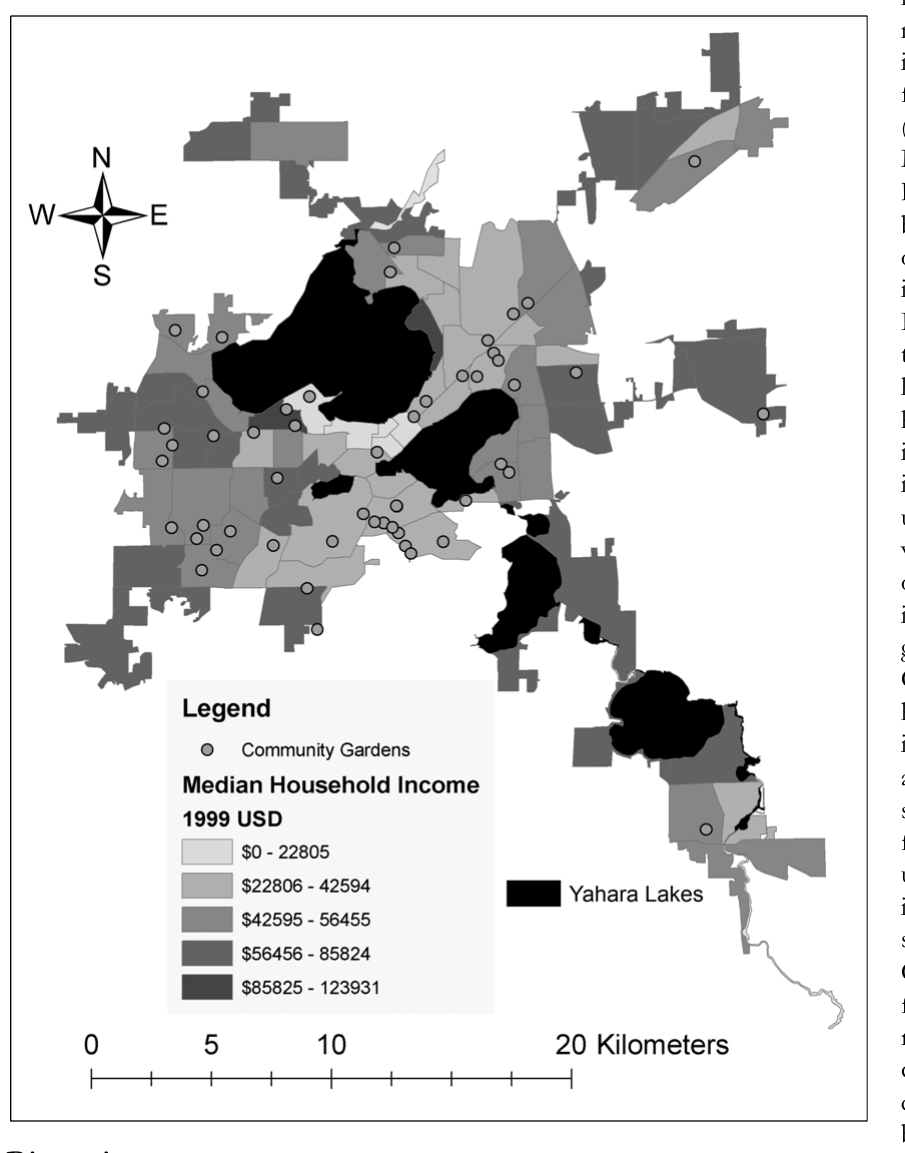
Figure 10. Community Gardens with Median Household Income by Census Tract Community garden presence appears distributed across median household income; however, many appear in areas of low median household